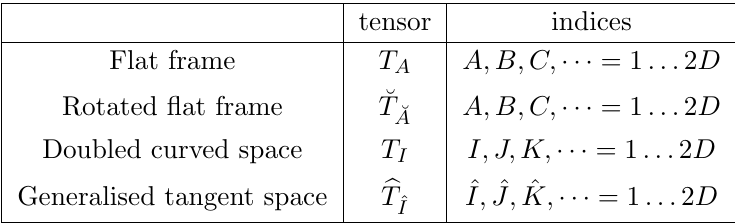
Table 3 . The variety of indices